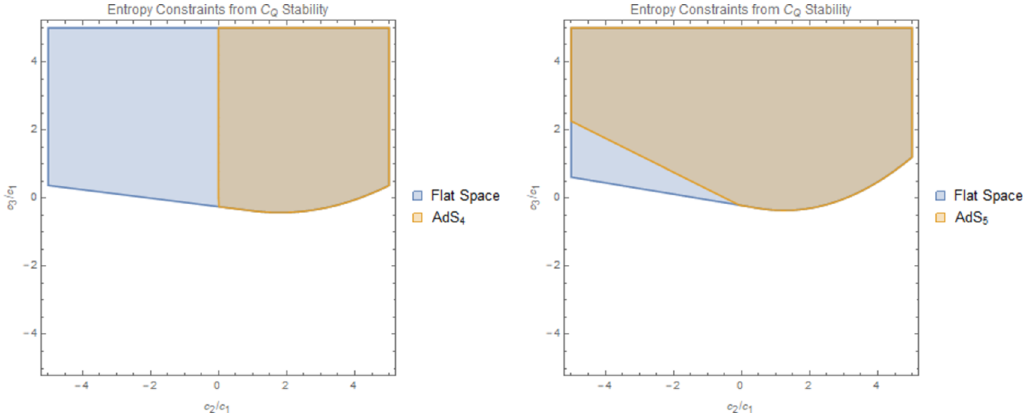
Figure 3 . The blue regions are allowed in (cid:13)at space and the orange in AdS{ note that the AdS regions are a subset of those from (cid:13)at